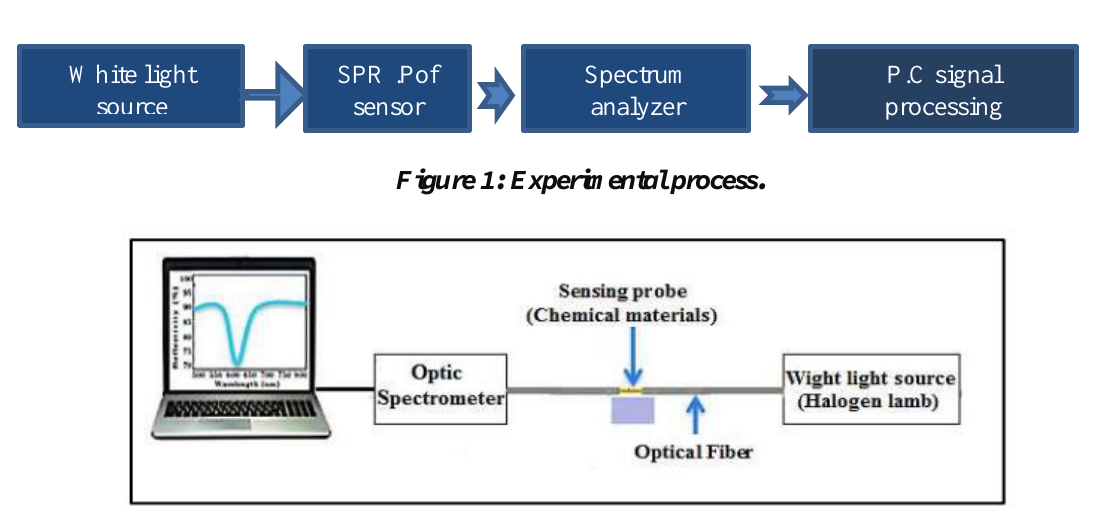
Figure 2: The diagram of the experimental setup for the optical fiber chemical sensor based on